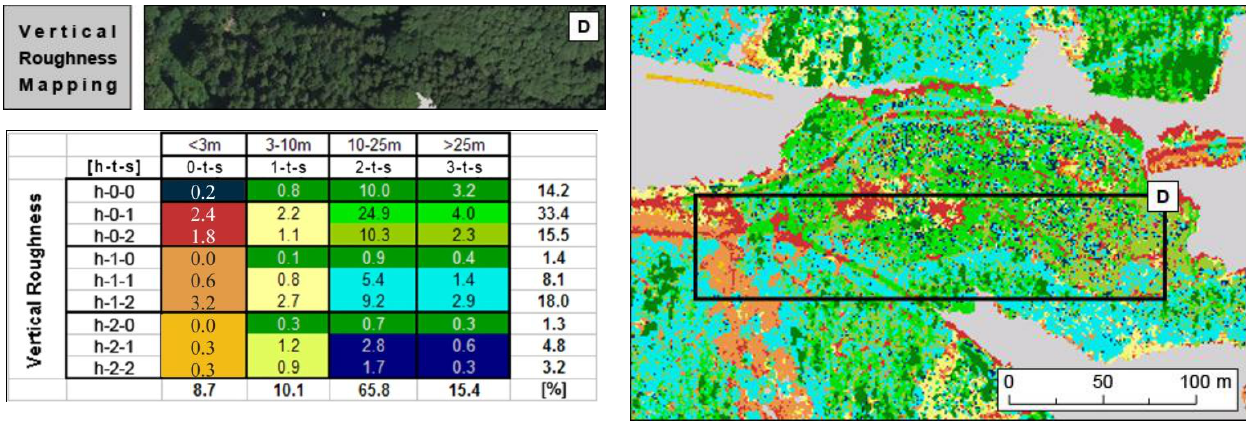
Figure 10. Vertical roughness map and classification scheme for a detailed area of the test site Bucklige Welt , and aerial image for comparison